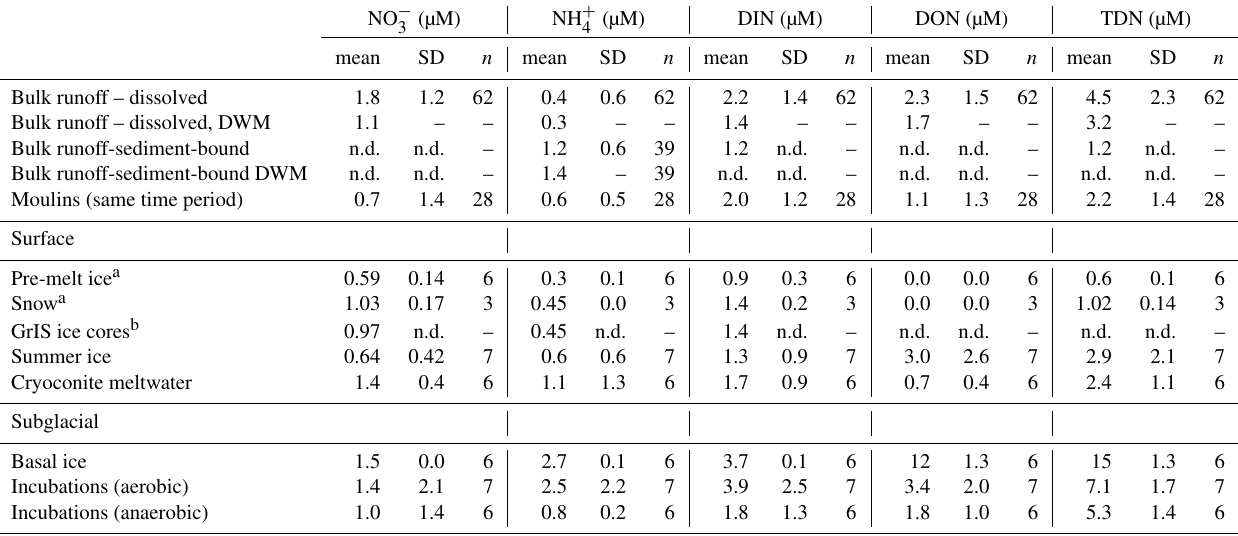
Table 1. Mean concentrations of nitrogen species reported in LG runoff (including discharge weighted mean, DWM for TDN species), in comparison to those in moulin waters, surface ice (pre-melt and post-melt “summer ice”, where the latter samples were at the melting temperature and contained dispersed debris), snow, cryoconite water and basal